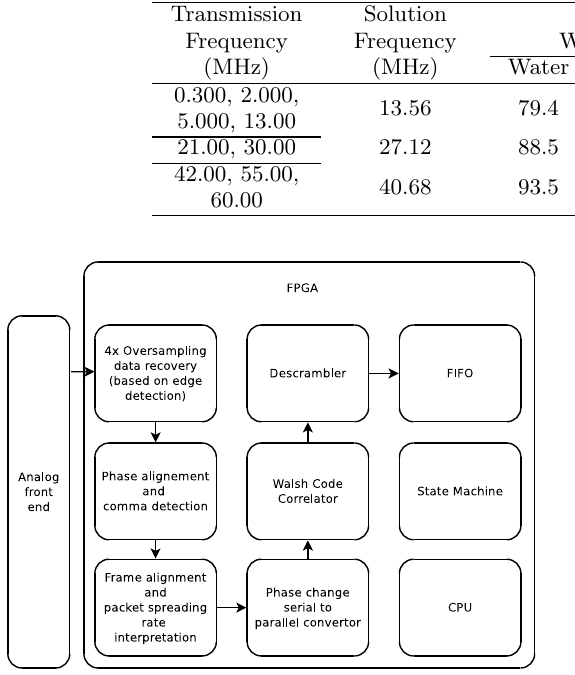
Figure 6: Prototype receiver architecture, as imple- mented in hardware using a Xilinx Virtex-5 FPGA device. A simulation of this hardware was used in order to allow detailed analysis of operation.